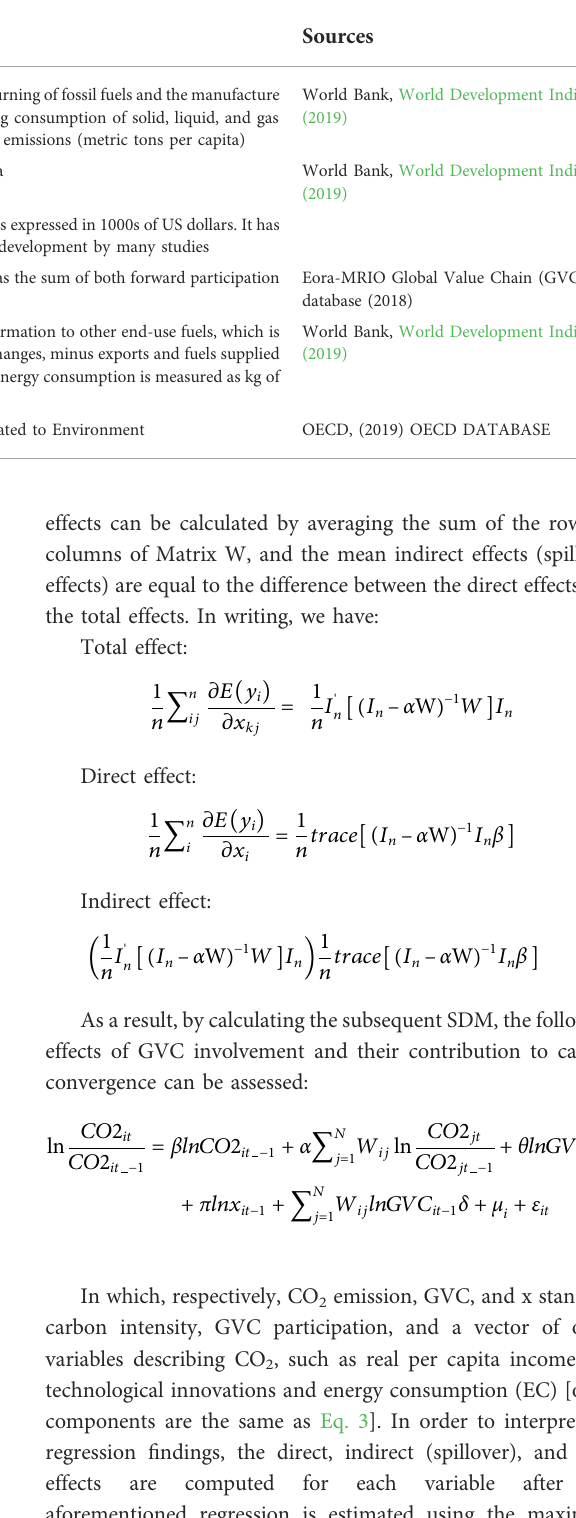
TABLE 1 Variables description and data